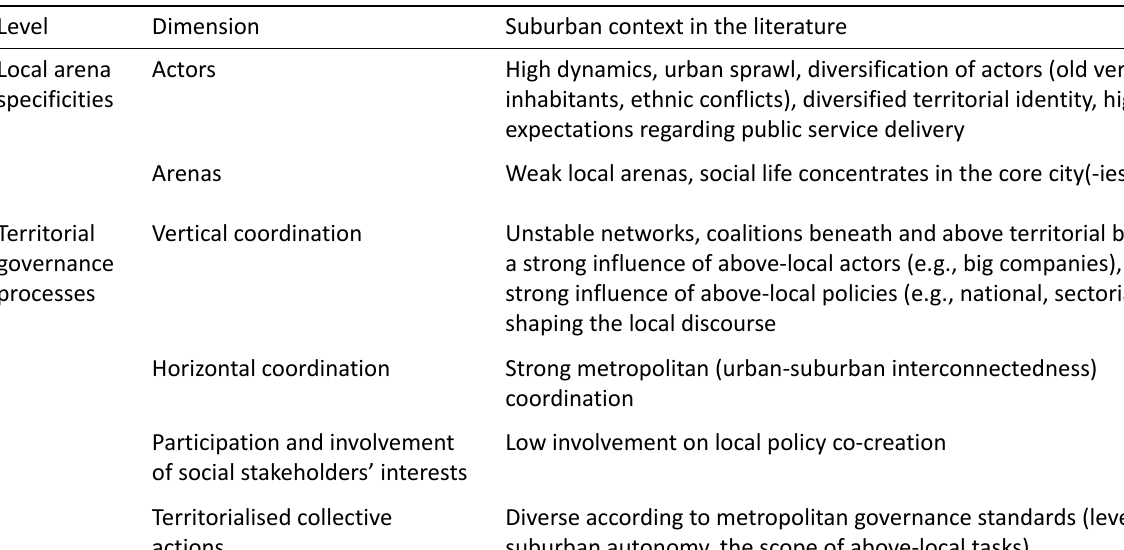
Table 1. Suburban specificities of territorial